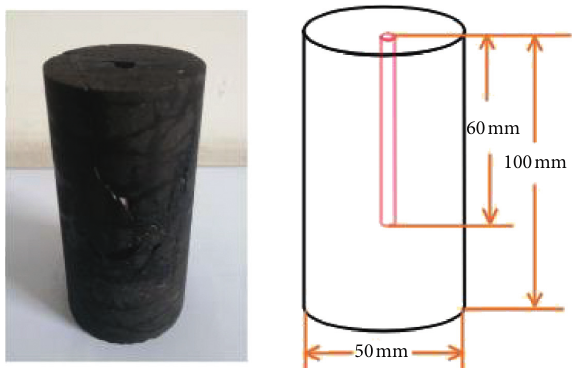
Figure 2: Coal samples for